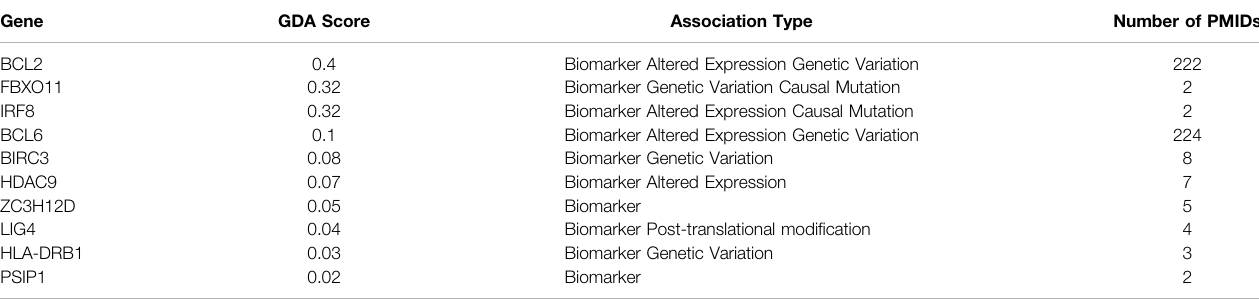
TABLE 3 | Top genes associated with DLBCL through